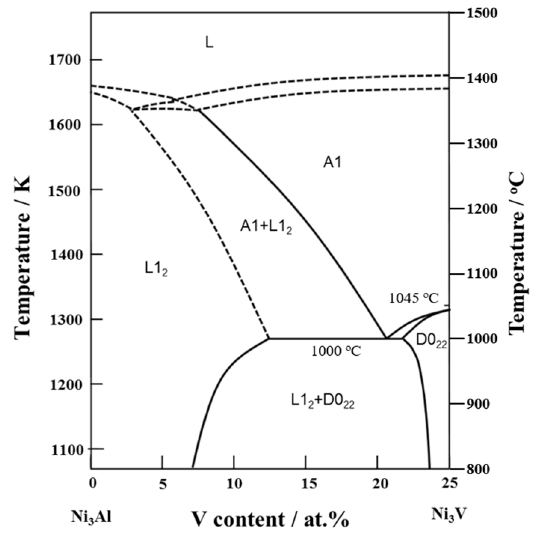
Figure 1. Ni 3 Al–Ni 3 V pseudo-binary phase diagram reproduced from [26], with permission from Elsevier, 2020. L1 2 denotes the ordered Ni 3 Al phase, Al the disordered face-centered cubic (fcc) phase, D0 22 the ordered Ni 3 V phase, and L the liquid phase.